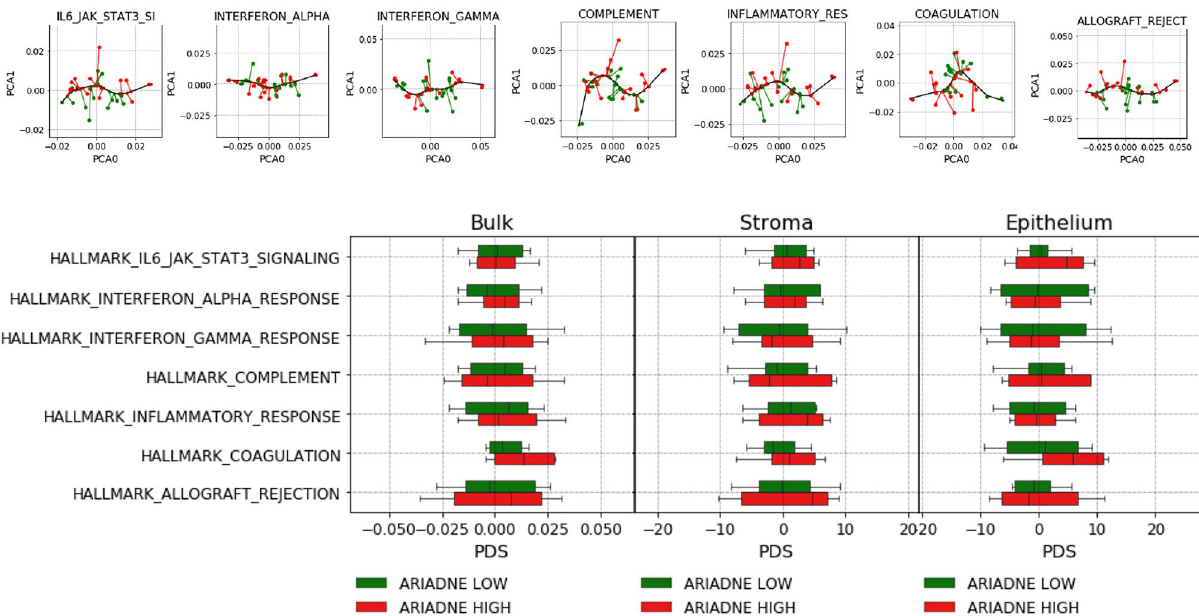
Figure 5. ARIADNE score is not correlated with pathway deregulation score for immune related hallmark pathways. Projections of bulk tumor samples of a set of immune related hallmark pathways (top panels). Boxplots of the PDS of each pathway separated by ARIADNE class for bulk tumor, stroma and epithelium (bottom panels).